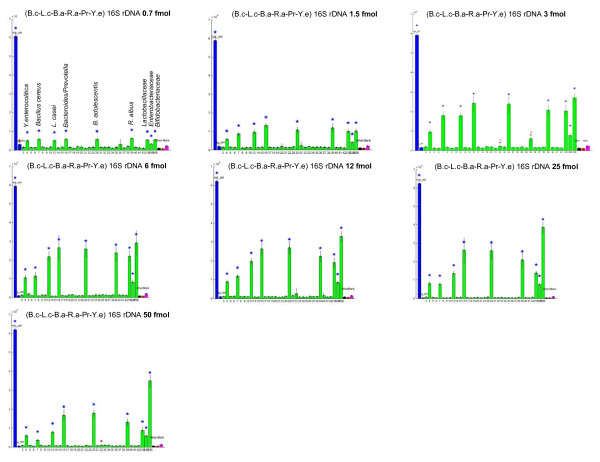
Complex mix of 16 rRNA amplicons. LDR-universal array experiments carried out on a complex mix of 16 rRNA amplicons obtained from six members of the human intestinal microbiota: B. cereus, L. casei, B. adolescentis, R. albus, Prevotella, Y. enterocolitica. Amplicons were tested in a concentration ranging from 0.7 to 75 fmol. Blue stars over the fluorescence bars indicate the probes that gave a positive response with a P < 0.01. Red dots indicate that one or two replicates out of four for each ZipCode were excluded because of having an IF < 2.5 times the average of the spots.